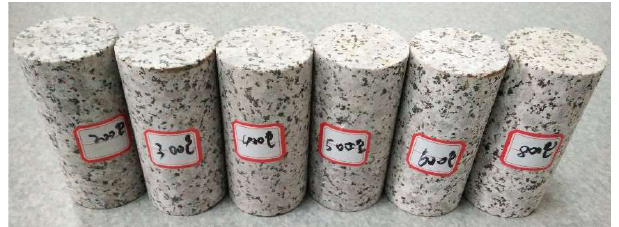
Figure 1. Tested granite samples after high-temperature exposure.